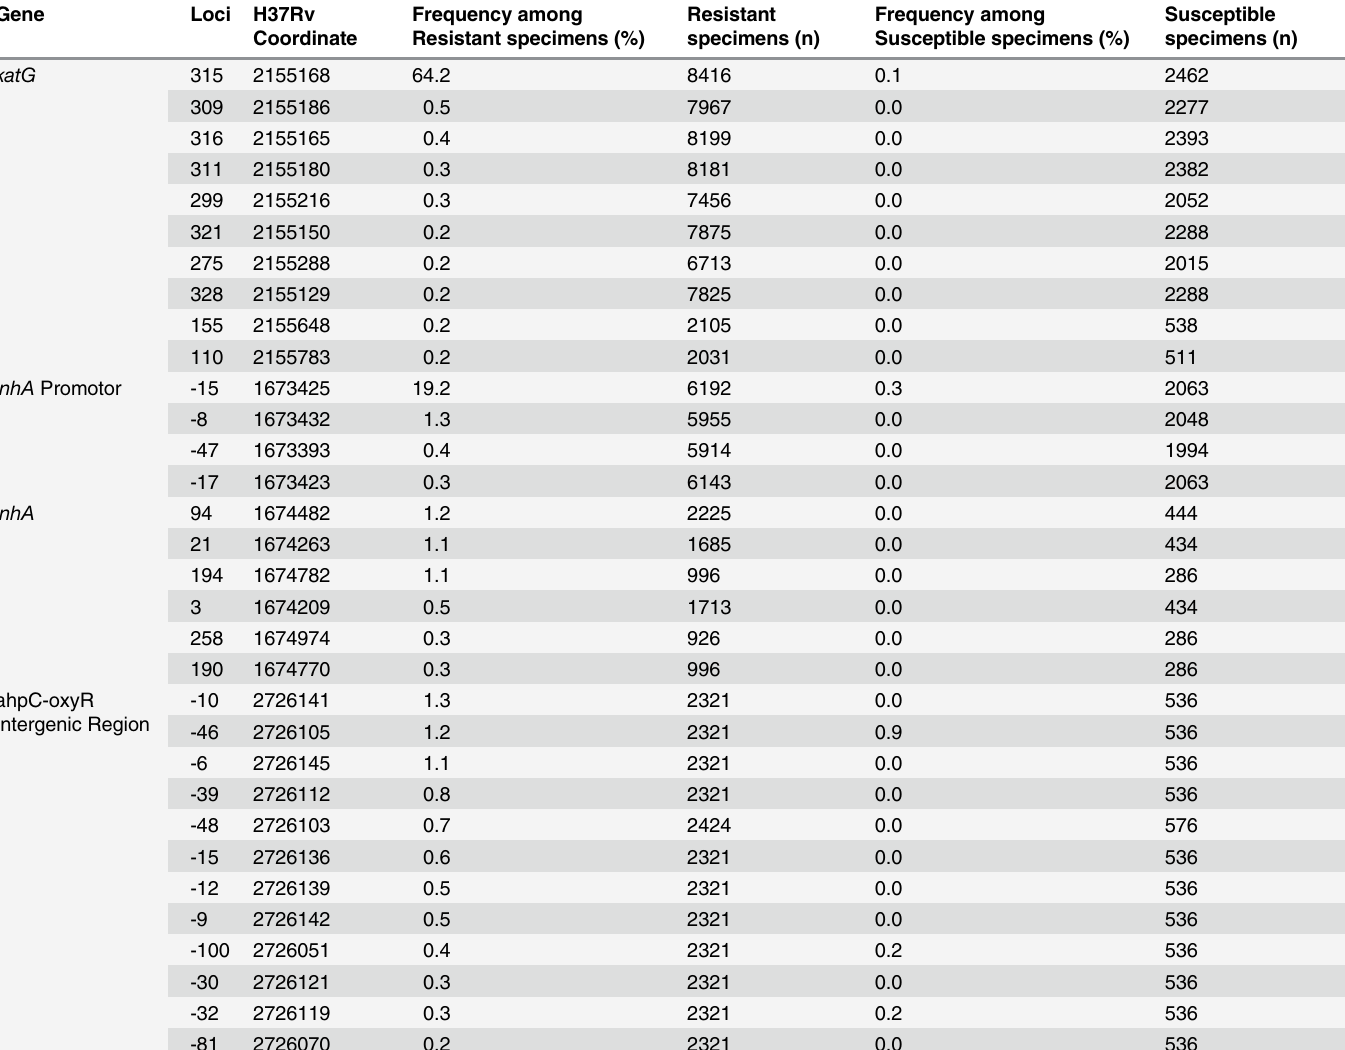
Table 1. Global frequencies for selected mutations among phenotypically isoniazid resistant and phenotypically isoniazid sensitive isolates. Gene Loci H37Rv Frequency among Resistant Frequency among Coordinate Resistant specimens (%) specimens (n) Susceptible specimens (%)